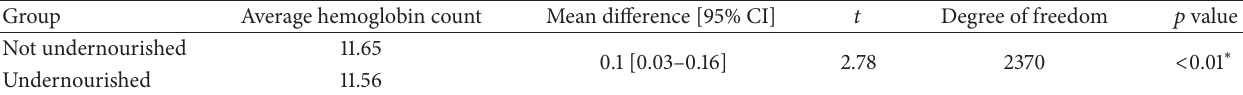
Table 5: Hemoglobin count and